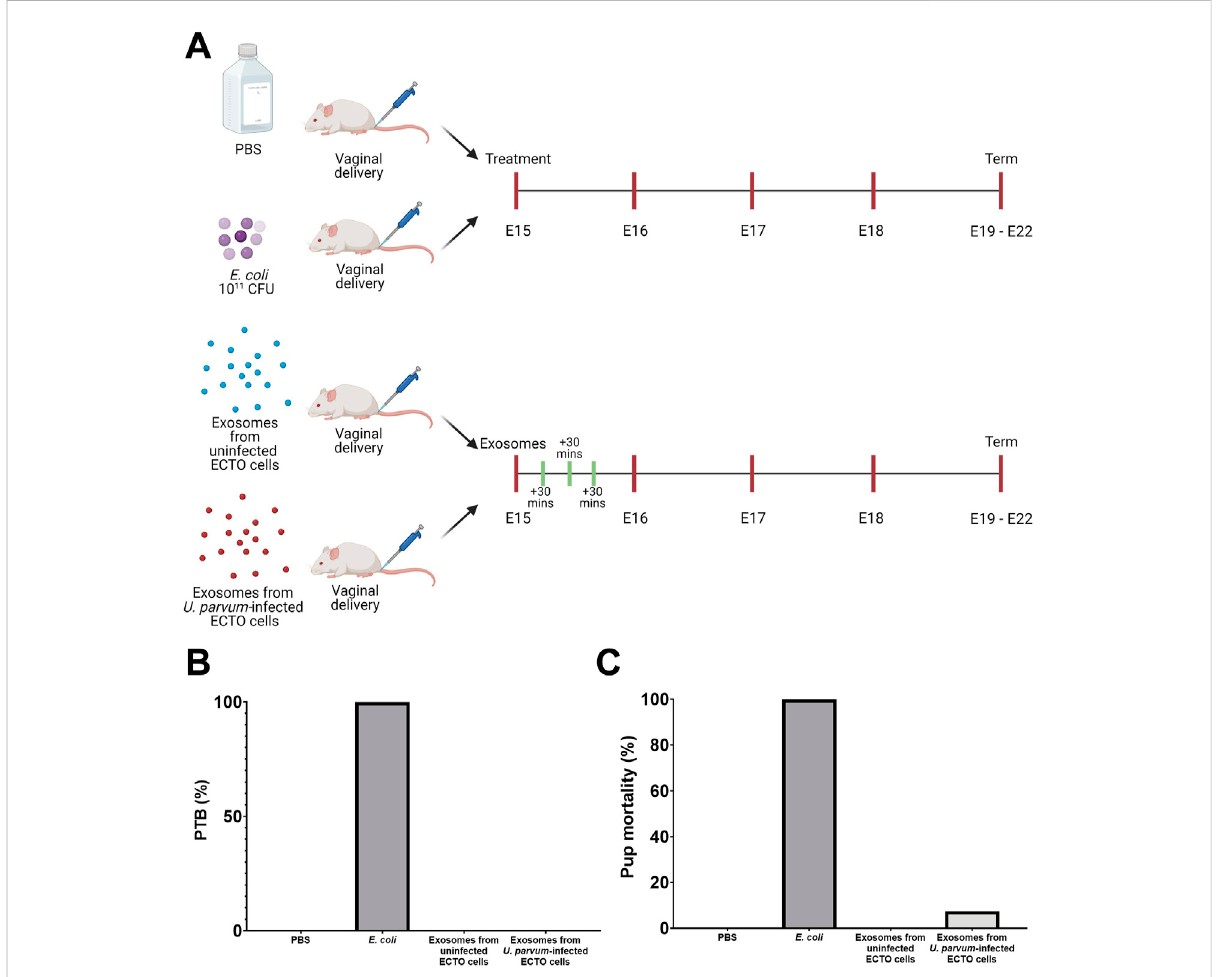
FIGURE 7 Preterm birth and neonatal death from exosomes from U. parvum- infected ECTO cells in CD-1 mice. (A) Schematic diagram of the in vivo experimentaldesign.E15pregnantmicewereinjectedvaginallywithexosomesfromuninfectedand U.parvum -infectedectocervicalepithelialcells. (B) Preterm birth rate and (C) pup mortality rate at birth after exosome treatment. For all groups, n ≥ 5 pregnant